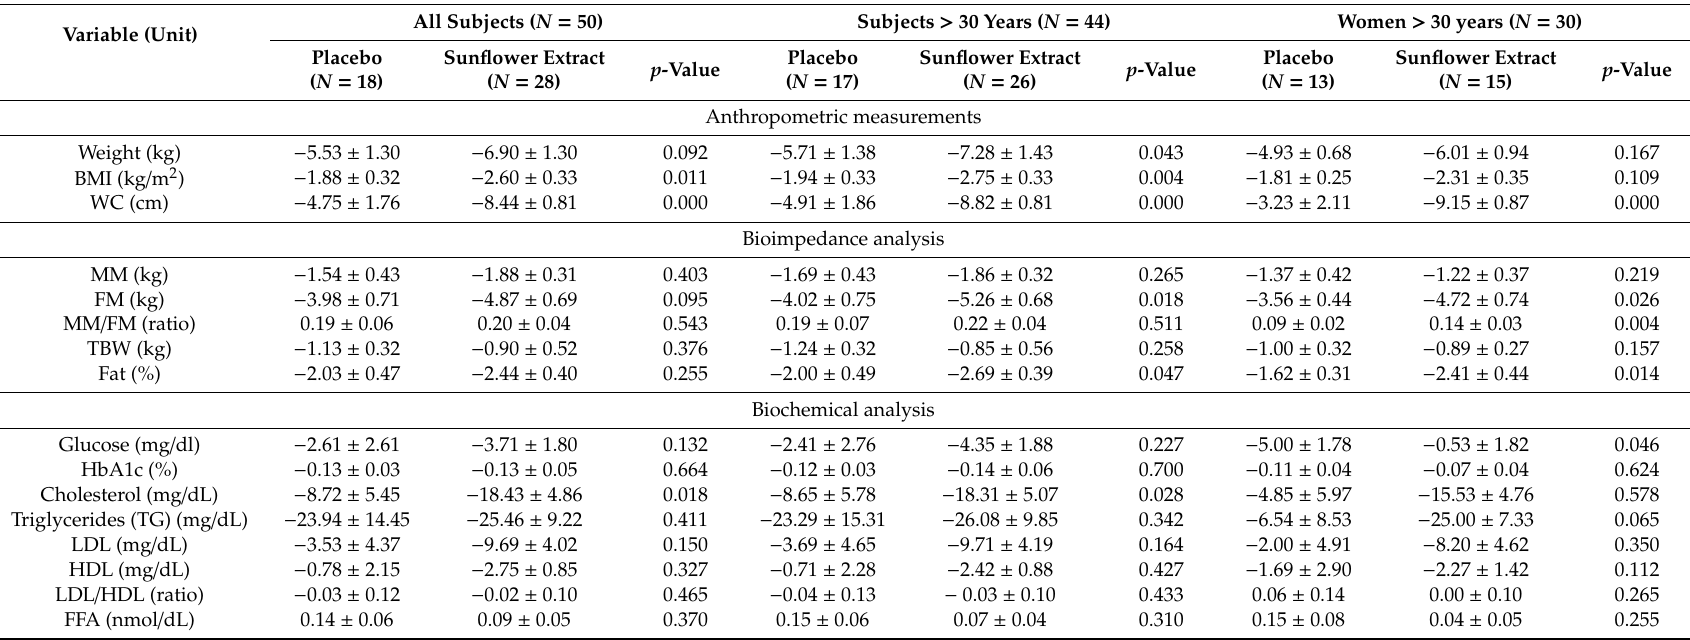
Table 3. Mean change values ± 1 × standard error of the mean from baseline to final visit (V5–V0) of outcomes